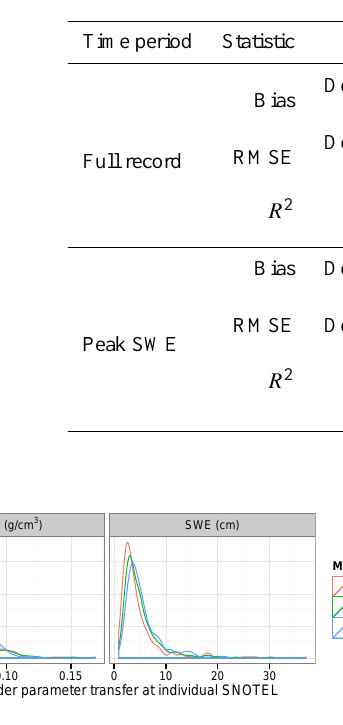
Table 1. Model skill statistics under parameter transfer for both the full record and a subset considering only the three weeks centered on peak SWE for each station and water year.